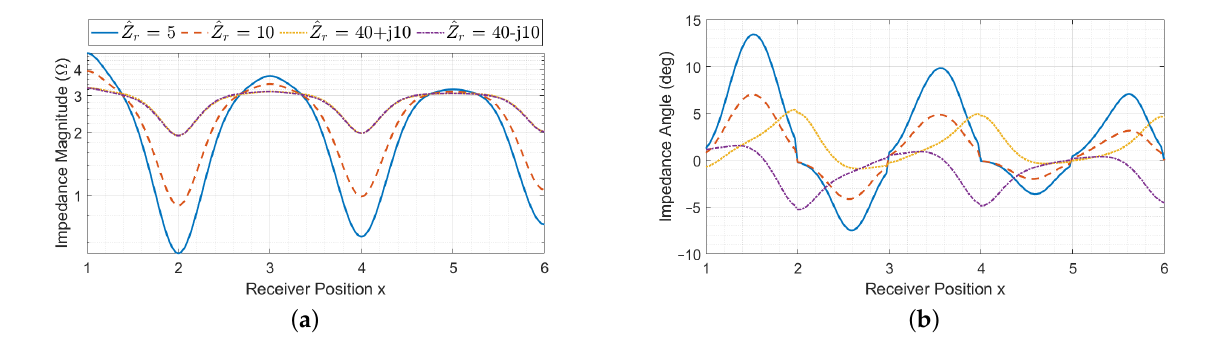
Figure 7. Array input impedance as a function of the receiver position with short-circuit termination for different values of the receiver impedance ˆ Z r , in magnitude ( a ) and phase ( b ).